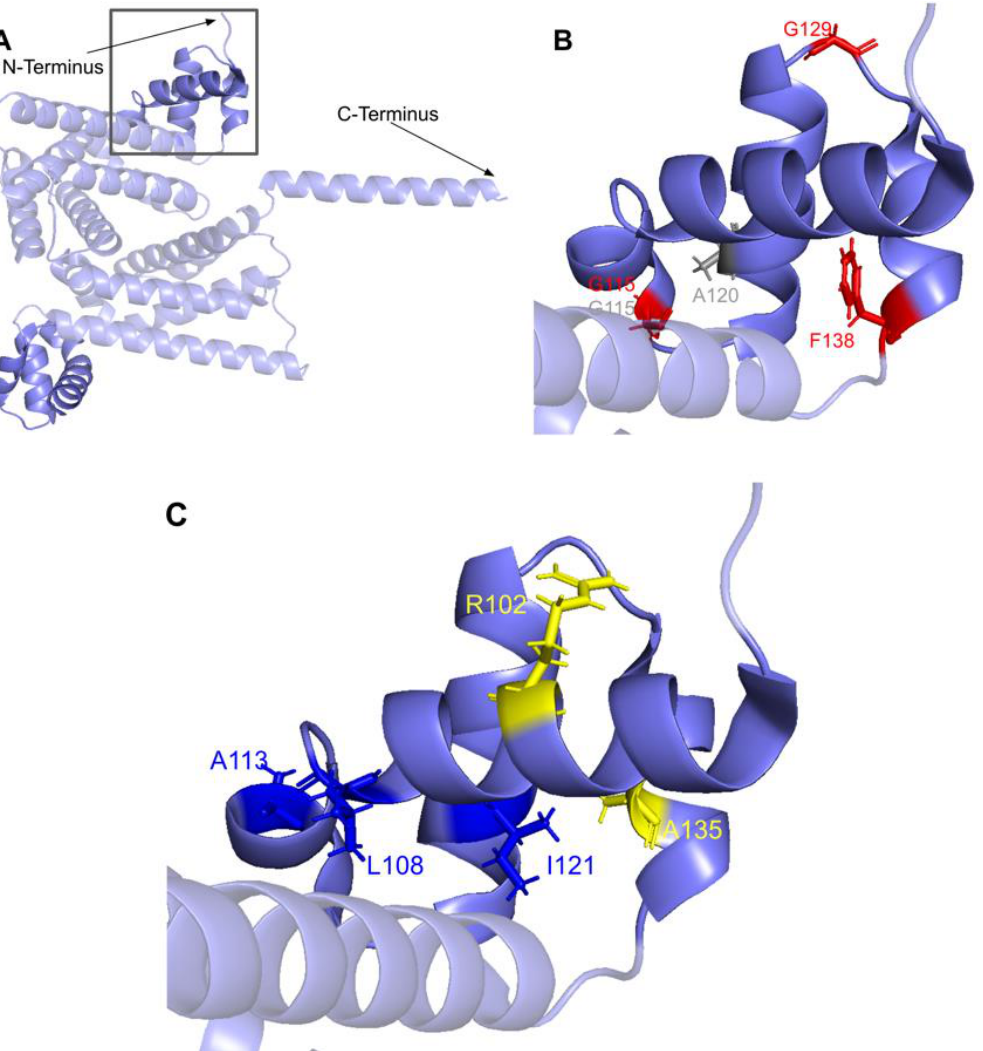
Figure 30. SNVs in the HTH-domain of COQ9. ( A ) N-terminal HTH-domains highlighted on the COQ9 dimer structure (PDB:6AWL), corresponding to residues S95 to F138 and D92 to F138, on chains A and B, respectively. ( B ) Locations of SNVs in conserved or functional regions are depicted. ( C ) Locations of ClinVar variants and frequent polymorphisms are depicted. Residues are colored according to their corresponding SNVs in Figure 28.